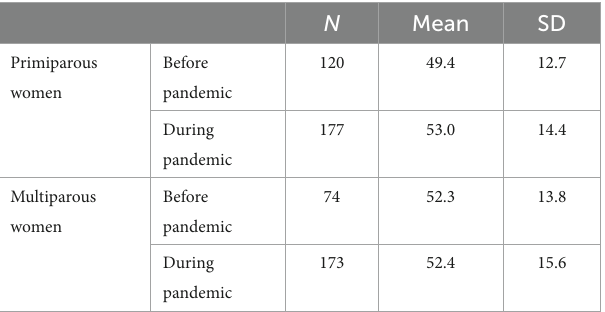
TABLE 4 The means of total disgust sensitivity scale (DS-R) before and during the pandemic separately for primiparous and multiparous women.